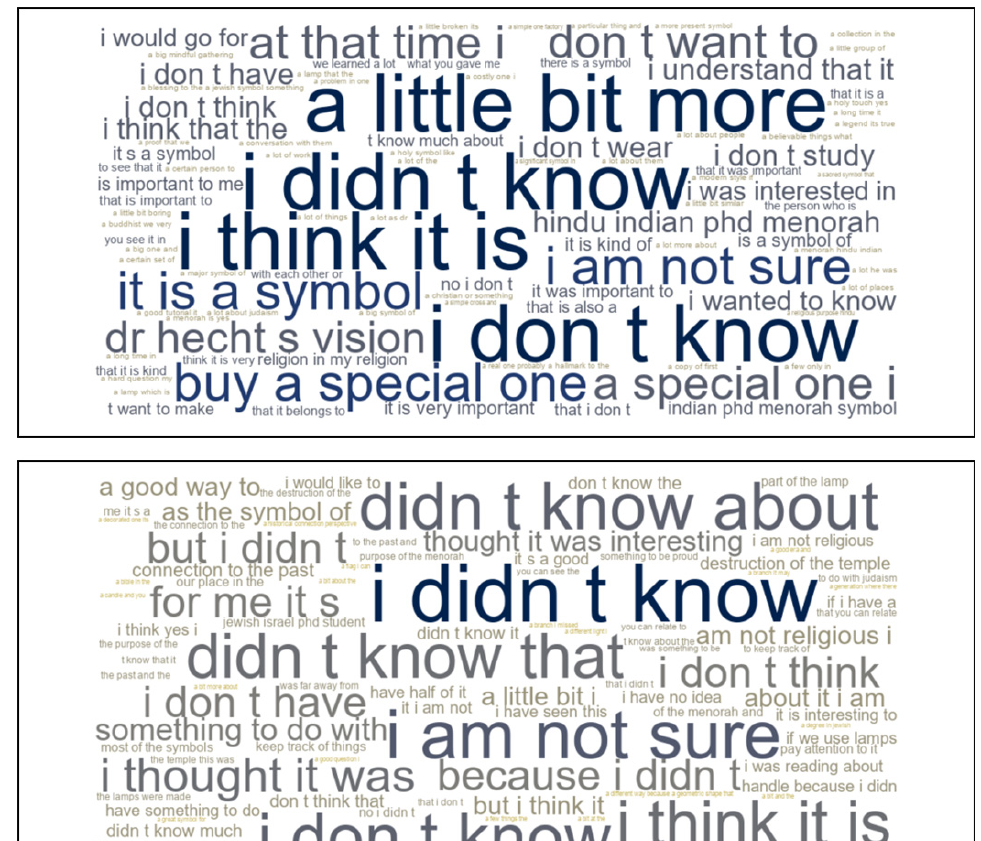
Figure 14. Word cloud generated by the 4 − word N − Gram analysis done on the responses to the Info version ( above ) and the Info + Values version ( below ) for the Prototype